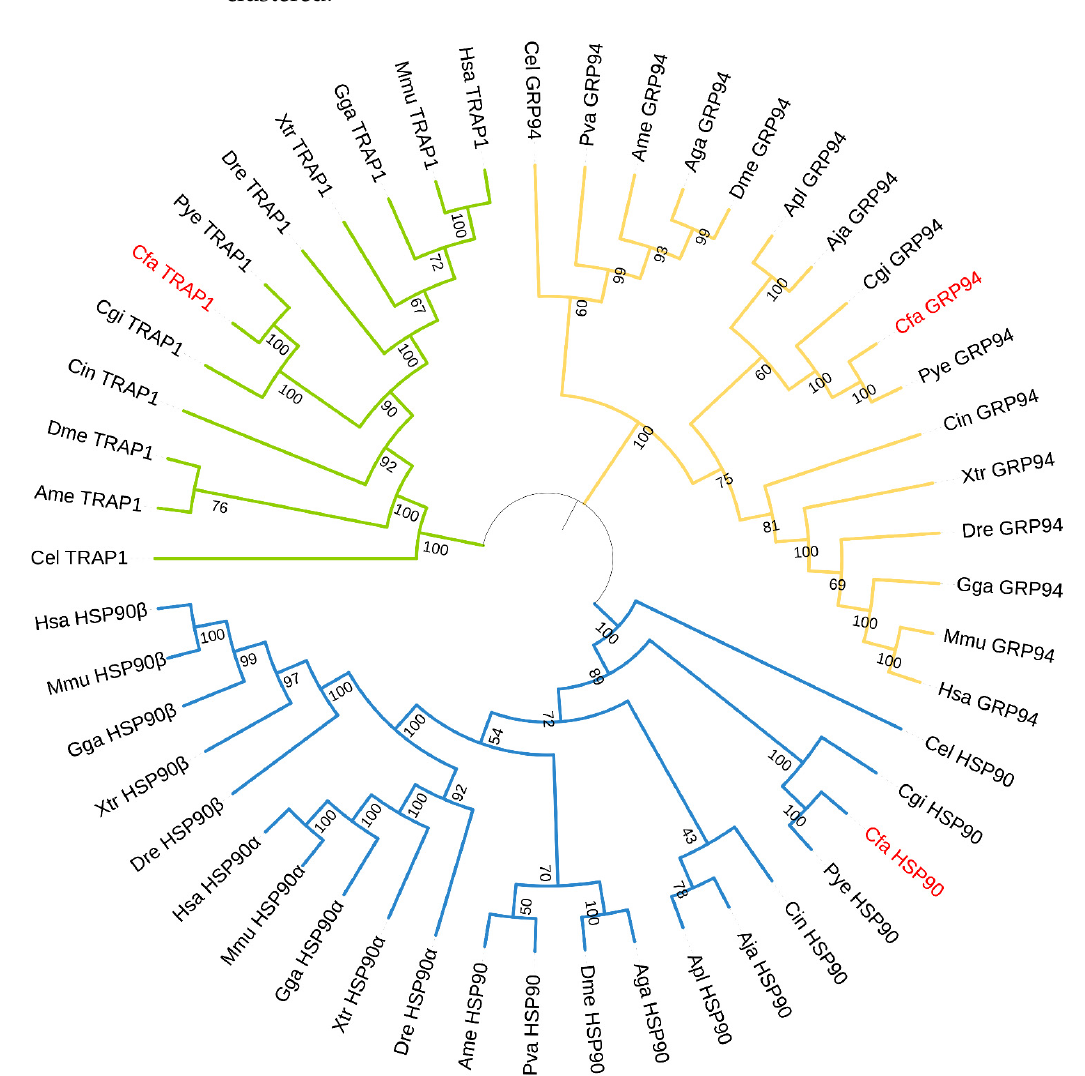
Figure 3. Phylogenetic tree of CfHSP90, CfGRP94, and CfTRAP1 with other HSP90s. The blue branches represent the HSP90 clade, the yellow branches represent the GRP94 clade, and the green branches represent the TRAP1 clade. CfHSP90 family is marked in red. The numbers under the tree branches indicate the bootstrap values from 1000 replicates.